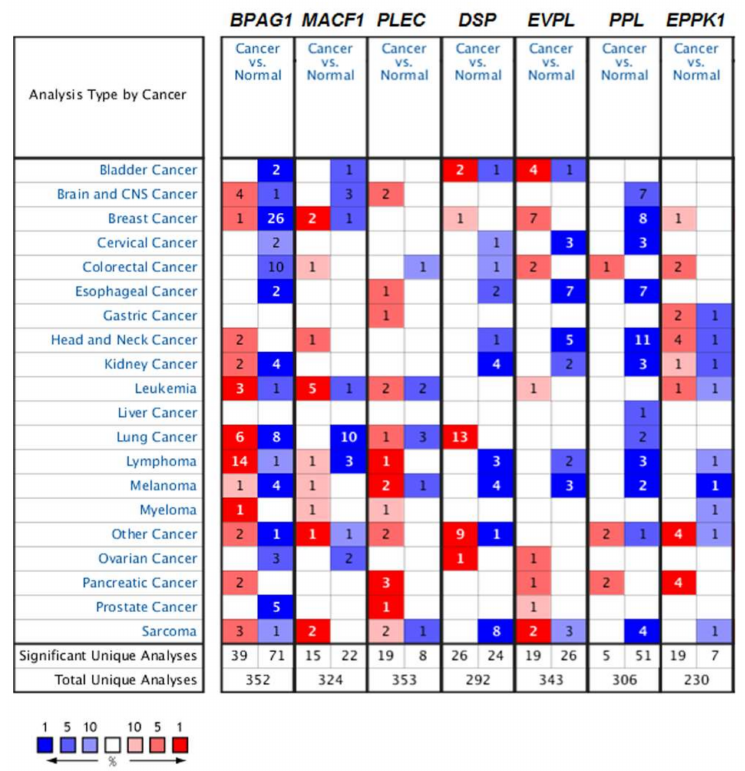
Figure 3. The expression levels of mammalian plakins across different cancers analyzed by Oncomine. The differences in expression levels of the genes between cancer and normal tissue are summarized in the graph. The graph demonstrates the numbers of datasets with statistically significant mRNA overexpression (red cell) or downexpression (blue cell) of the target gene. The number of unique analyses satisfies the threshold settings: p value is 0.01, fold change is 2, gene rank is top 10%, data type: mRNA. The gene rank is indicated by the color depth in the cells. PLEC : plecitn; DSP :